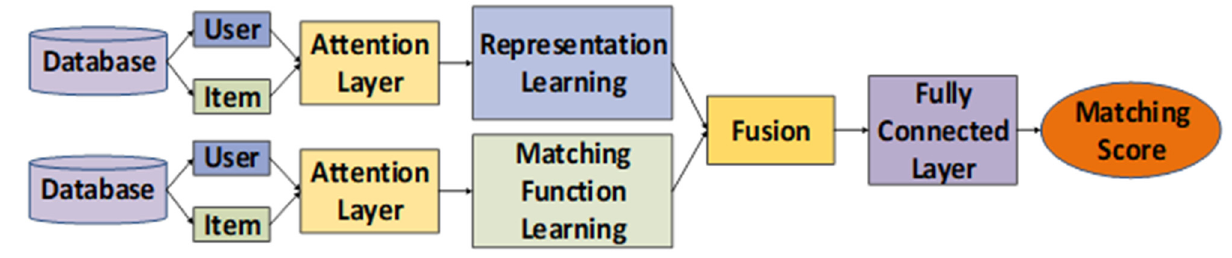
Figure 1. The general process of DACR.